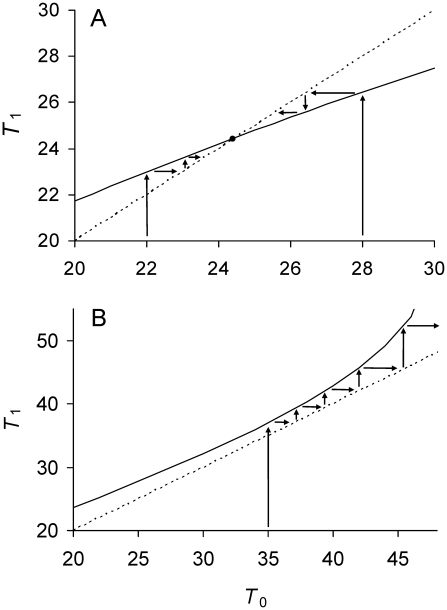
Phase plot of relationship between doubling times of daughter and mother cells when division is symmetrical.Daughter cell doubling time T
1 predicted by Equations 3, 5, and 6 for a given mother doubling time T
0 (——) with symmetry. One solid line is presented because with symmetry both daughter cells have the same doubling time. Time is measured in minutes. See Table 1 for complete definitions of model variables and parameters. (A) Low damage rates; a = ½, Π = 20, λ = 0.005, and Πλ = 0.10. Dynamics of bacterial lineages can be represented on the phase plane by mapping T
0 to the solid line to derive T
1. The next cell division of the lineage is obtained by allowing the daughters cells to become mother cells and divide, which is accomplished graphically by projecting T
1 to the T
0 axis. The projection is facilitated by mapping T
1 to the identity line (----; T
1 = T
0). For example, if T
0 = 22 min, the predicted T
1 is 23 min. Projecting 23 min to identity line and then upwards to the solid line yields 23.6 min, which corresponds to the T
1 of the next division. The successive divisions lead the lineage to the intersection of the solid and identity lines at 24.5 (•). The increase in doubling times corresponds to aging. The intersection denotes the stable equilibrium point  because a mother cell starting at T
0 = 28 tracks backwards to the same point by a process of rejuvenation. The equilibrium is locally stable if the slope of the solid line at the intersection is less than one [34]. The equilibrium value of 24.5 is also predicted by Equation 10 by letting Π = 20 and λ = 0.005. This equilibrium is possible in the model because the lifetime damage rate of Πλ = 0.10 is less than the threshold of 1/6 (Equation 11). (B) High damage rates; a = ½, Π = 20, λ = 0.009, and Πλ = 0.18. Because Πλ>1/6, Equation 11 is not satisfied, the solid line does not cross the identity line, and  does not attain a real value. If cell division were projected graphically into future generations, T
1 increases to infinity.